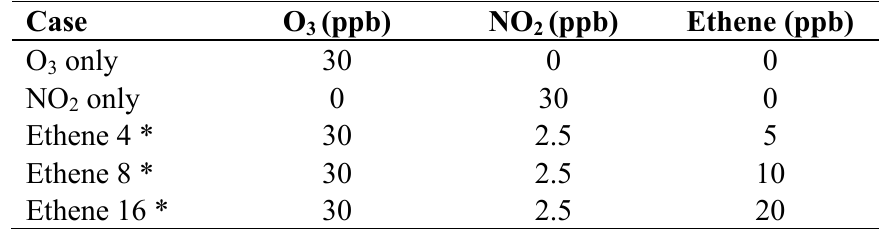
Table 2. Simplified simulations made to illustrate atmospheric chemistry